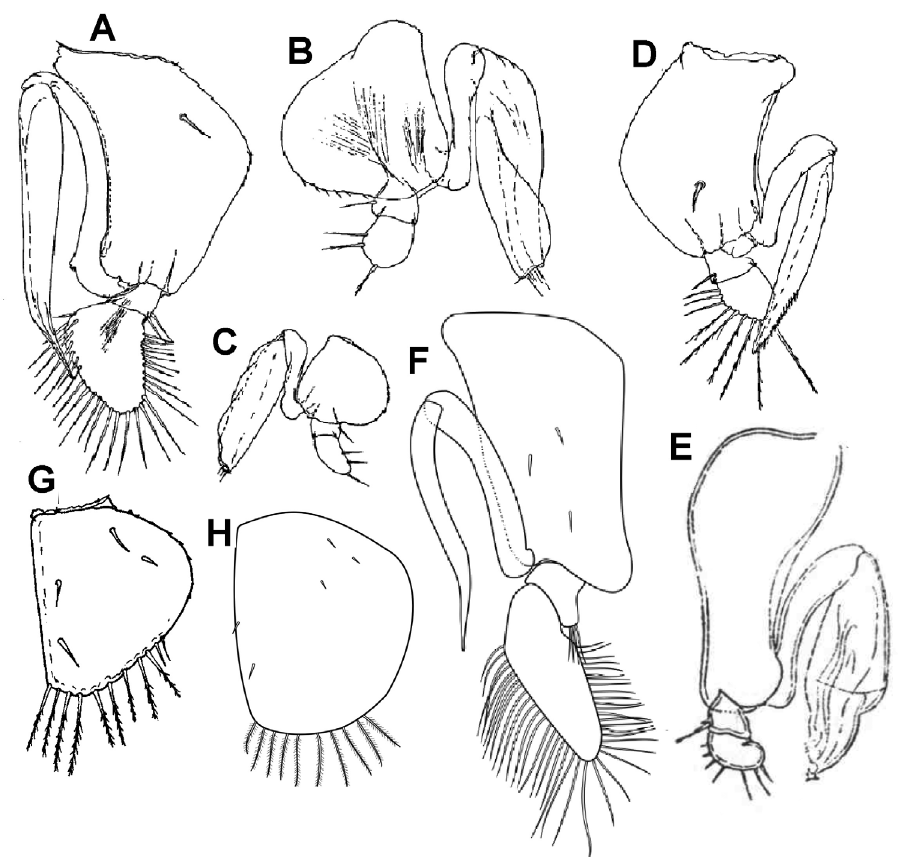
Figure 6. Male pleopod II of Stenasellus vermeuleni ( A ) S . henryi ( B ) S . grafi ( C ) S . messanai ( D ) S . asiaticus ( E ) and S . tashanensis sp. n. ( F ). (Figures A–D from Magniez and Stock 2000; Figure E from Birstein and Starostin